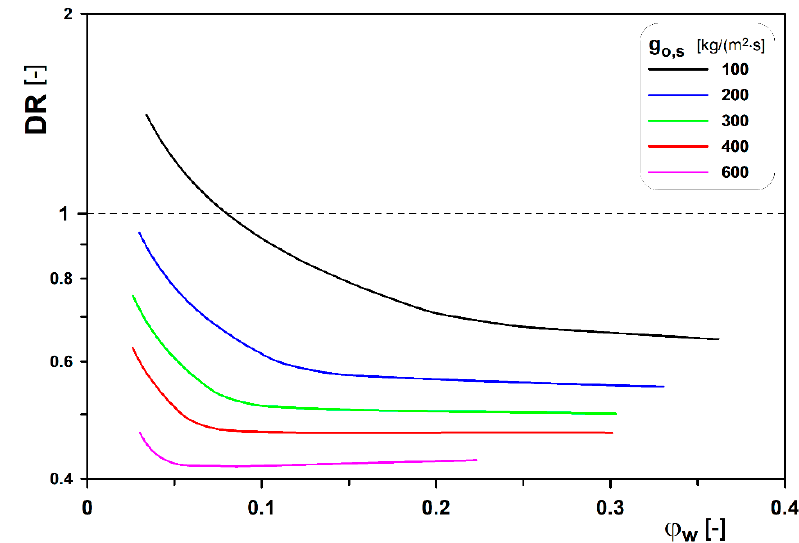
Figure 5. Variations in the DR index for oil with a viscosity of η r =100.